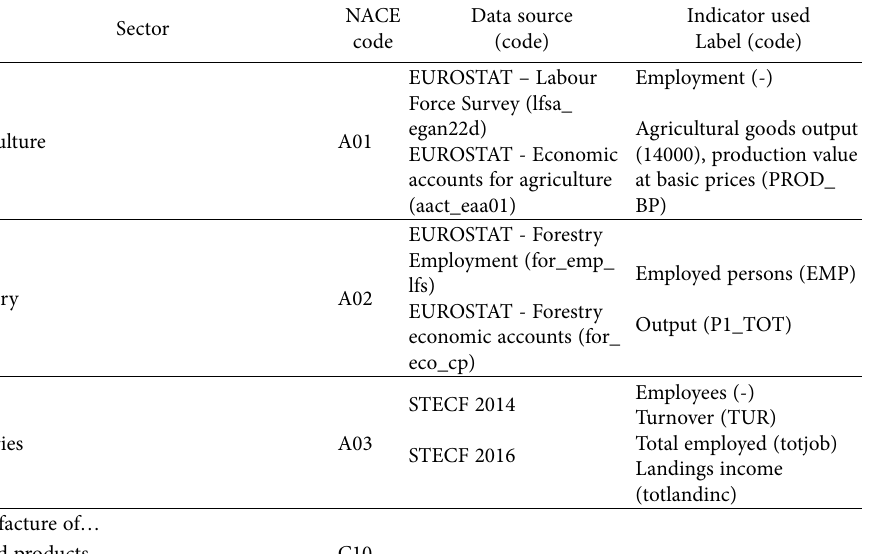
Table 1. Activity sectors covered in this study, with data sources and indicators